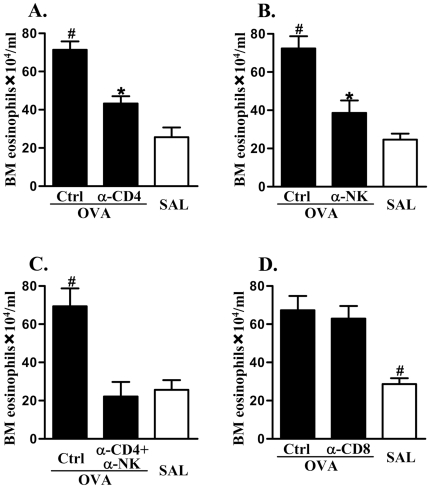
The effects of depletion of CD4+ and CD8+ T cells and NK cells on the development of eosinophils in the bone marrow in the absence of STAT6.(A) Anti-CD4 and (B) anti-NK cell (anti-ASIALO GM1) antibody significantly suppressed the increased development of eosinophils in the bone marrow of OVA/OVA treated STAT6-deficient mice. Combined treatment with (C) anti-CD4 and anti-NK antibodies completely abolished the increased development of eosinophils. By contrast, (D) anti-CD8 antibody had no effect. #P<0.05 compared to other groups. *P<0.05 compared to SAL/OVA treated mice.